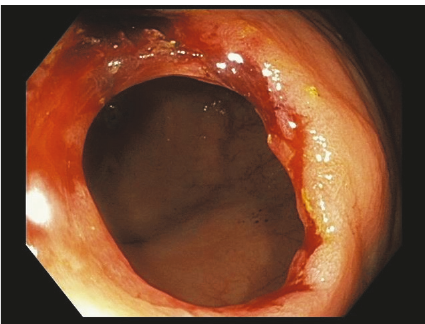
Figure 3: Endoscopic view of the ascending colon with resolution of diaphragm-like stricture, scarring, and ulceration.